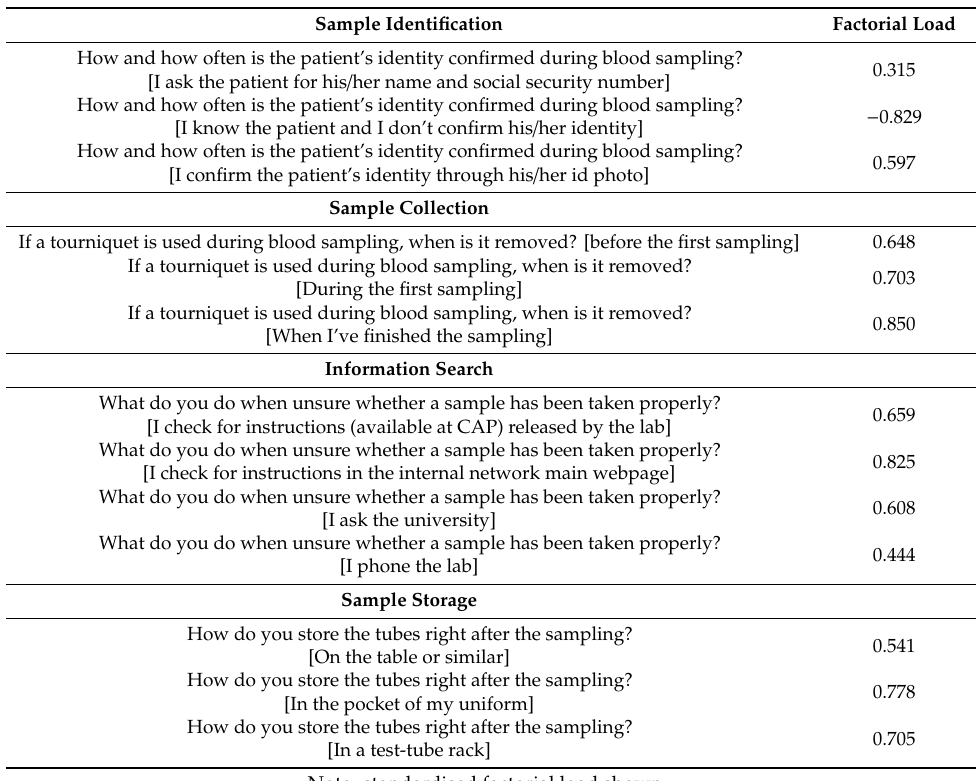
Table 1. Standardised factorial load of “Sample Identification”, “Sample Collection”, “Information Search”, and “Sample Storage”. (Source: